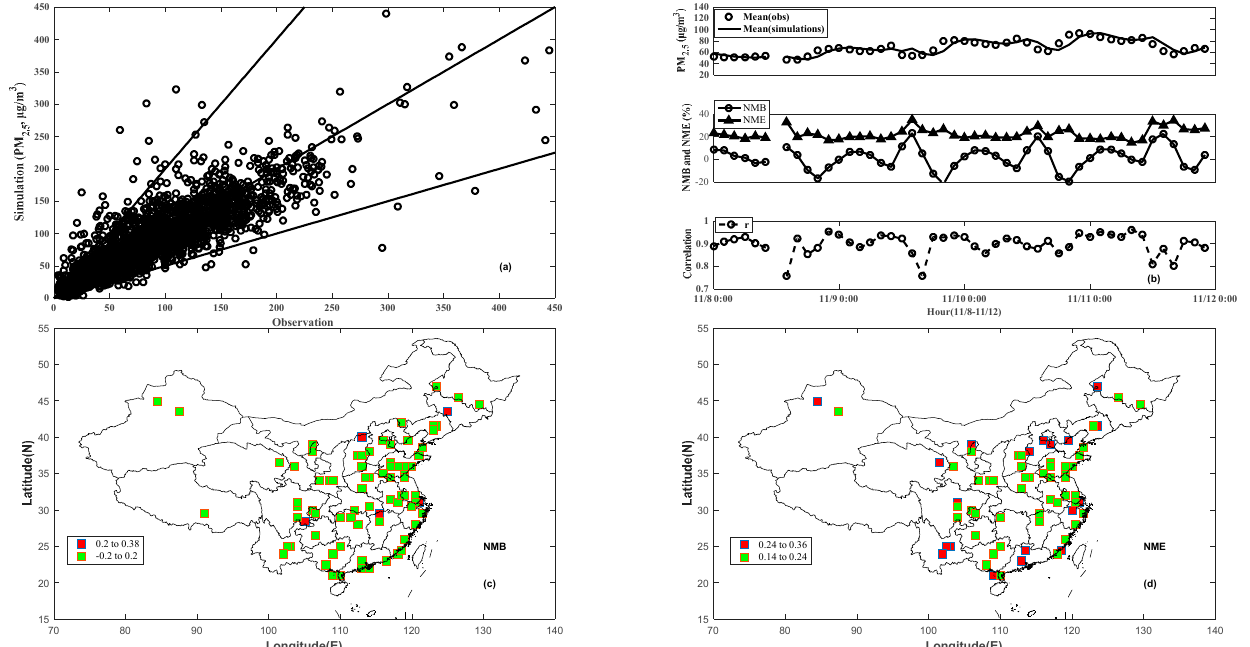
Figure 6. Comparison of the simulated and observed PM 2.5 concentrations on November 8–11, 2014: ( a ) scatter plot ( µ g/m 3 ) (the 0.75:1, 1:1 and 1.25:1 lines are shown for reference), ( b ) variation of spatial mean, NMB, NME and correlation (r), and spatial distribution of ( c ) NMB and ( d ) NME.